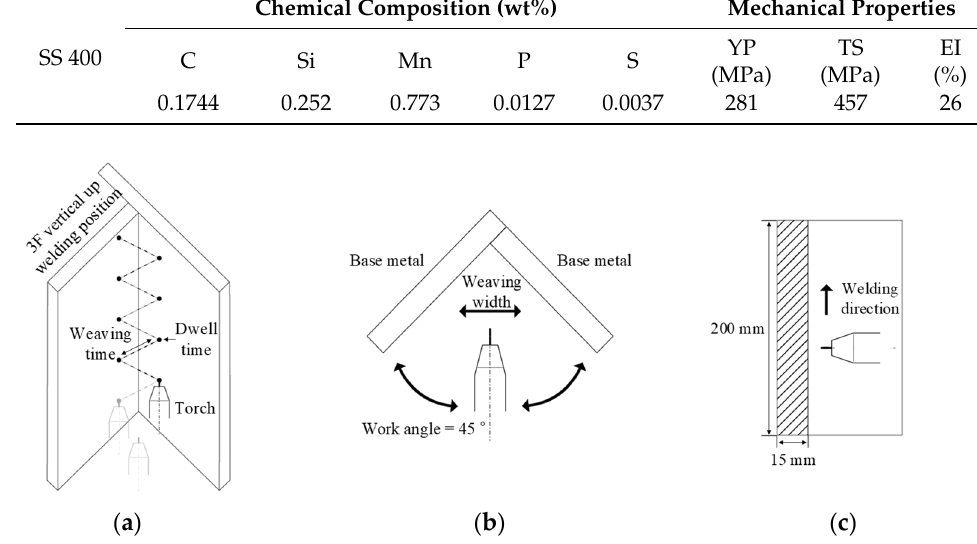
Figure 1. Dimensions and schematic of the test plates in 3F vertical up welding position: ( a ) overview, ( b ) top view, and ( c ) side view. ( b ) top view, and ( c ) side Table 1. Chemical composition and mechanical properties of the base metal.